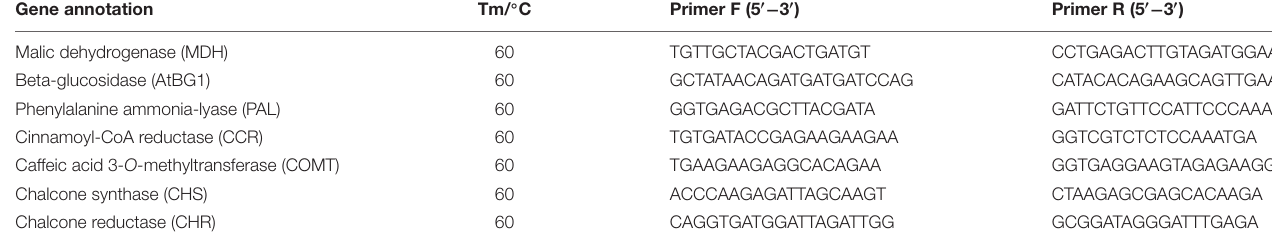
TABLE 1 | Primer sequences used for qRT-PCR for detecting gene expression. Gene annotation